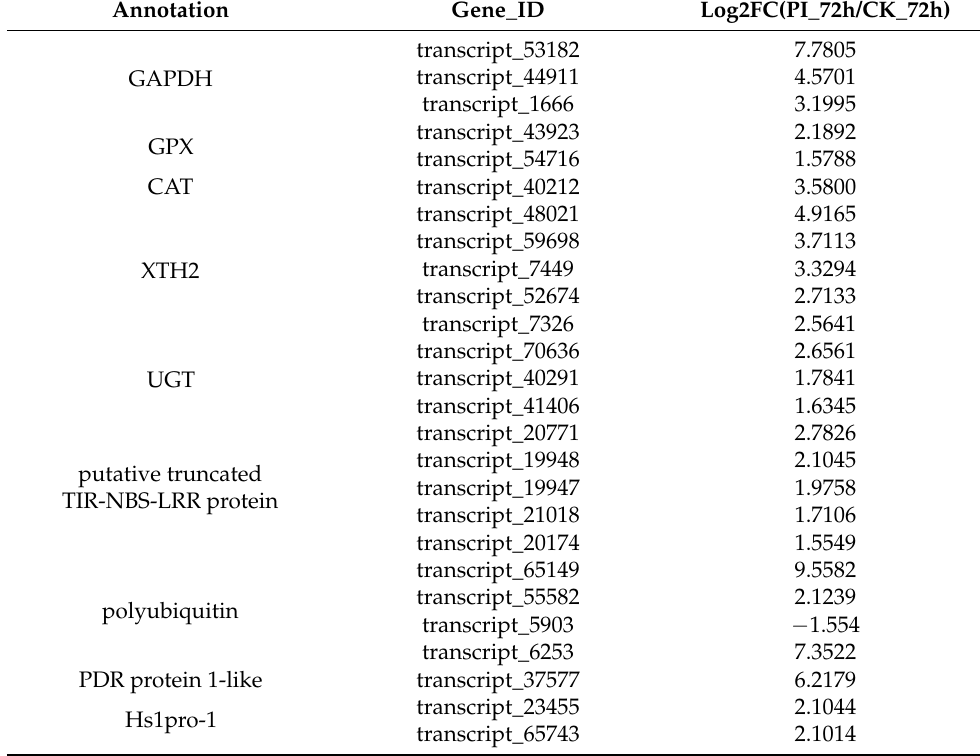
Table 4. DEGs expression under the S. noctilio venom stress of Mongolian